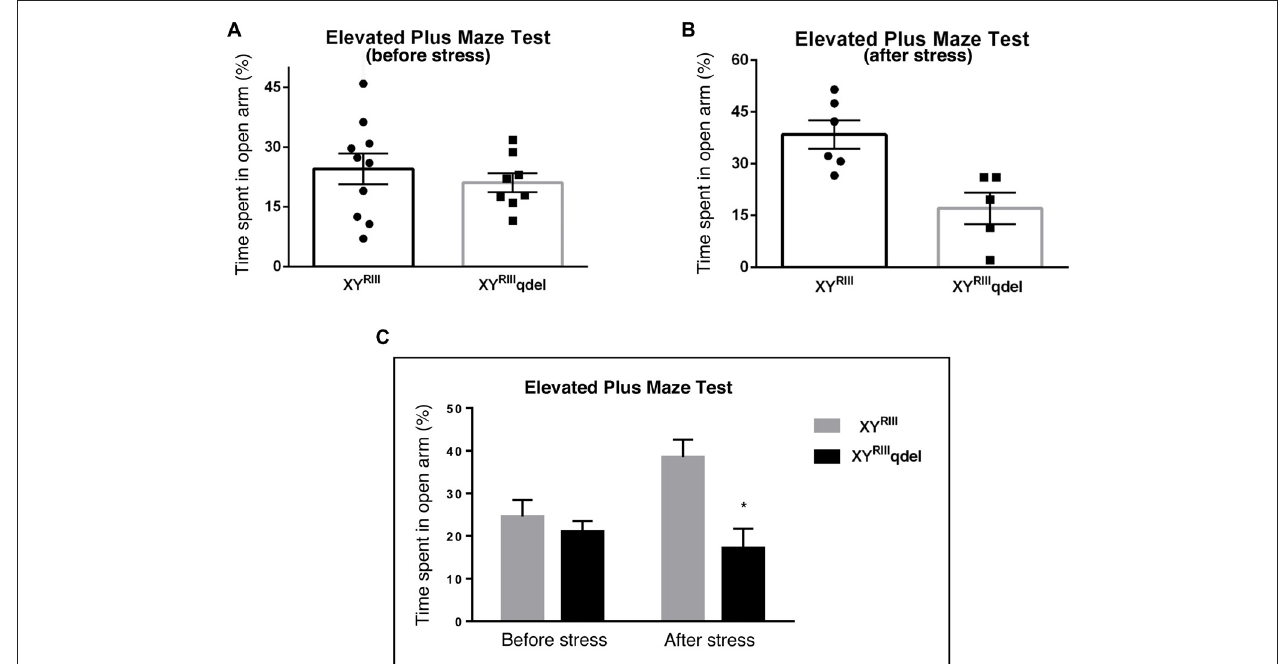
FIGURE 2 | The status of anxiety in XY RIII qdel and XY RIII mice was evaluated by elevated plus maze test (EPM) before and after the exposure of the stressors. Before the mice have undergone stress paradigm, the status of anxiety in XY RIII qdel did not differ from the wild type as shown by scatter bar plot (A) whereas in the same test they showed significantly more anxiety phenotype by spending remarkably less time in open arm on stress response (B) . Combined bar graph is shown to compare the effect of before and after stress (C) . Data are expressed as the mean ± SEM, ∗ P < 0.05, n = 8–10 per group in before stress, n = 6–8 per group in after stress